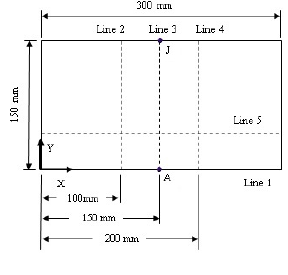
Figure 5. The considered path.